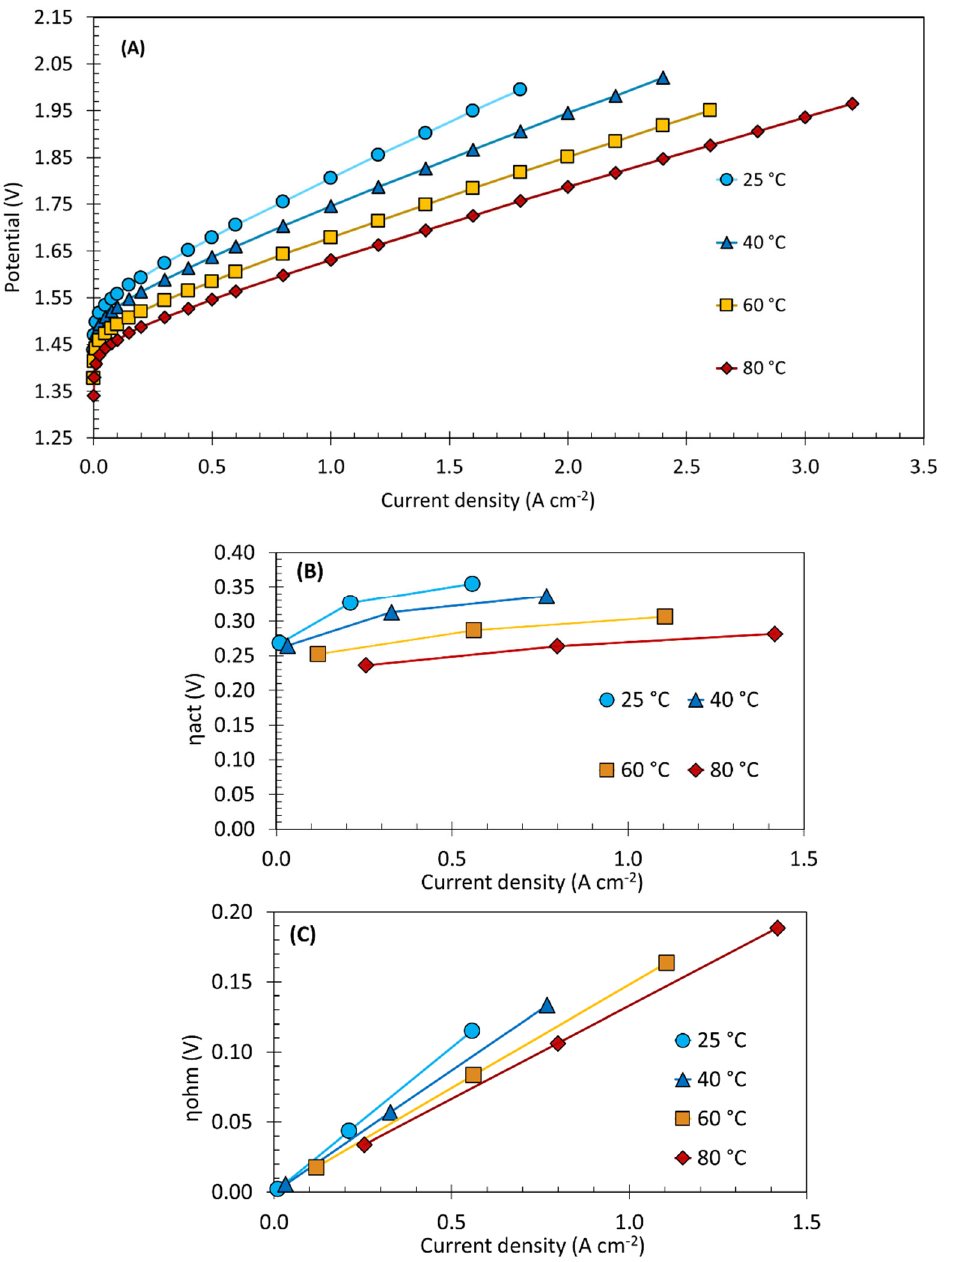
Figure 6. Operating temperature effect of the QuinTech CCM at different temperatures. ( A ) ‐ I ‐ V curves, ( B ) ‐ activation overpotentials, ( C ) ‐ ohmic overpotentials.